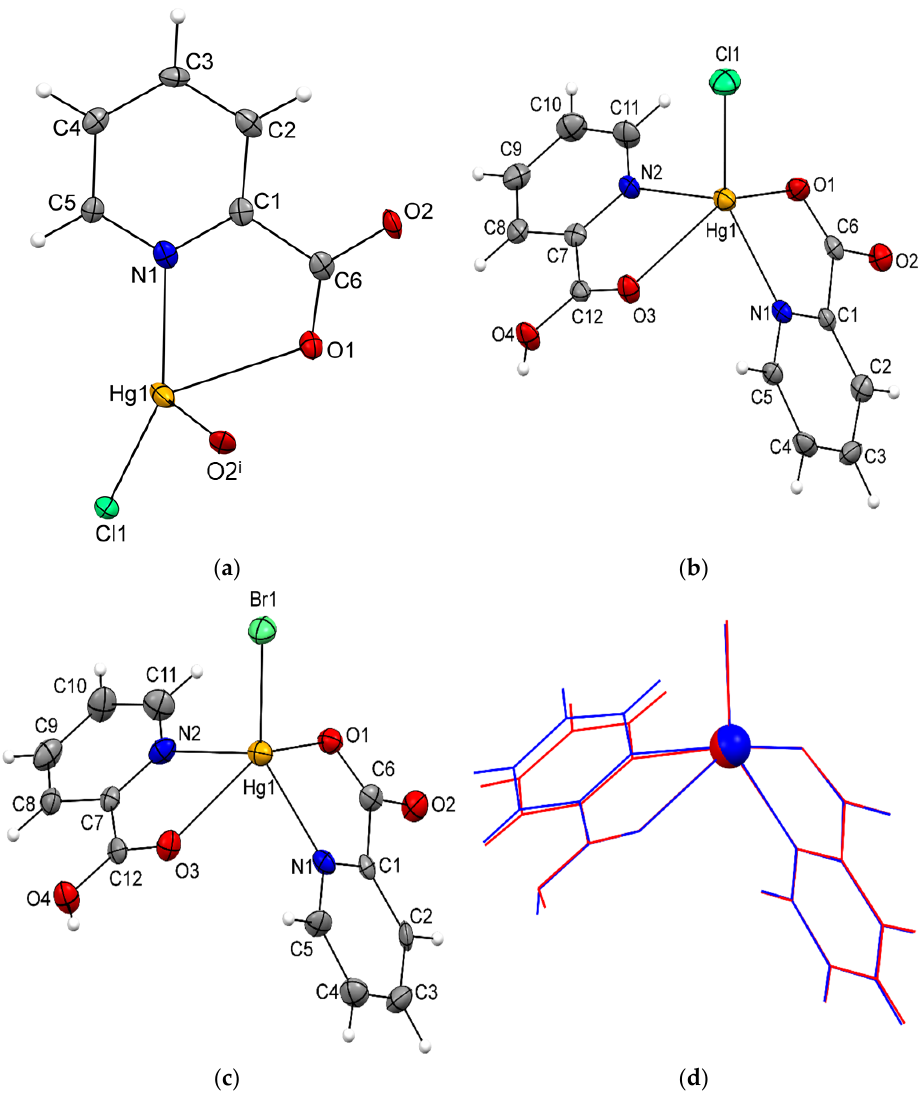
Figure 1. ORTEP-style plots of {[HgCl(pic)]} n ( 1 ) ( a ), [ HgCl(pic)(picH) ] ( 2 ) ( b ), and [HgBr(pic)(picH)] ( 3 ) ( c ), with the atomic numbering schemes. Thermal ellipsoids are drawn at the 40% probability level at 170(2) K, and hydrogen atoms are shown as spheres of arbitrary radii (symmetry code (i): x , − y + 3/2, z + 1/2). Overlay (RMS value of 0.0556 Å) ( d ) of molecules of [HgCl(pic)(picH)] ( 2 ) (blue) and [ HgBr(pic)(picH) ] ( 3 ) (red). The Hg, N, O, and halide atoms were chosen for the overlay.